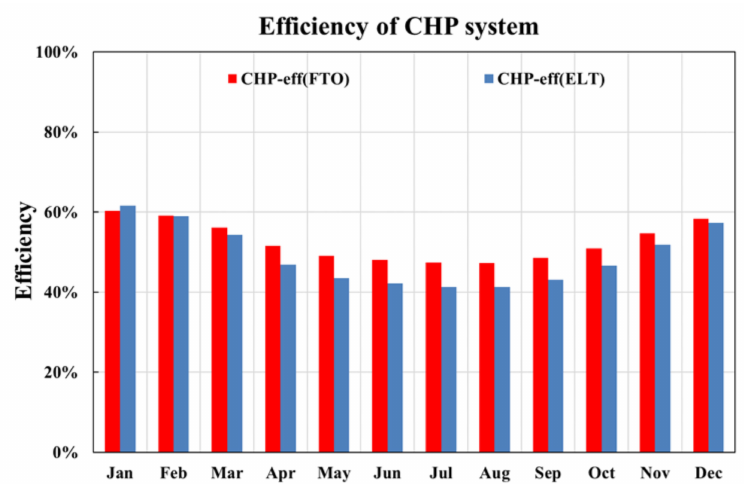
Figure 13. Total efficiency of the fuel cell under the FTO and ELT operating models.